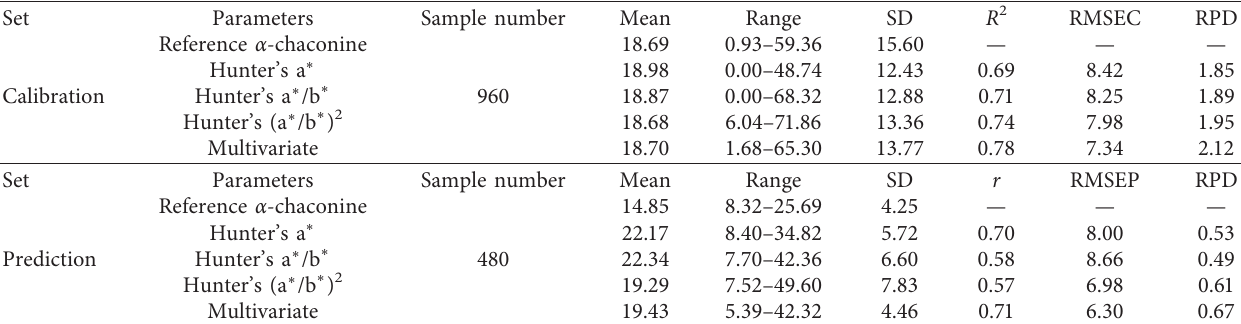
Figure 3). The RMSECV values for Hunter’s a ∗ , a ∗ /b ∗ ,